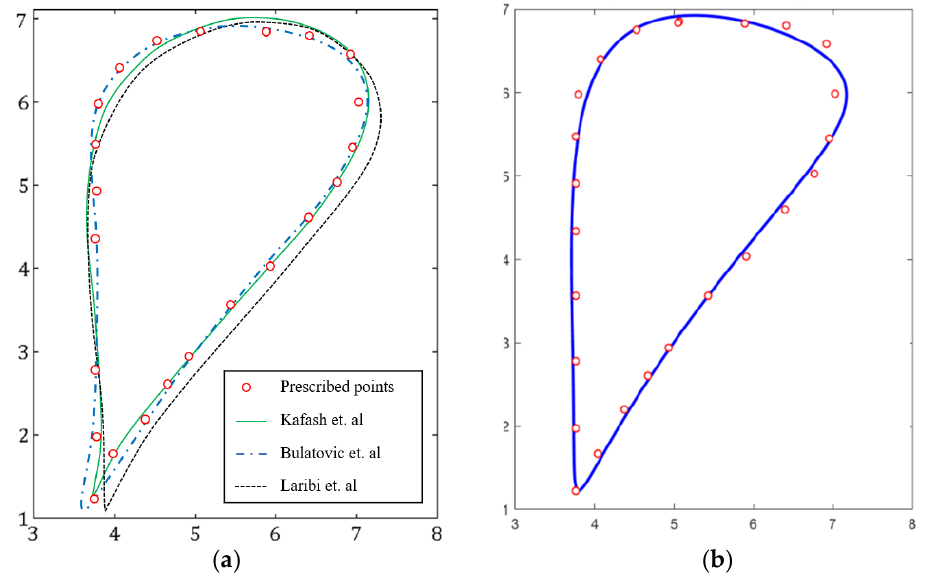
Figure 10. Example 2: optimal solution for: ( a ) four-bar and ( b ) slider-crank mechanism. Table 3. Example 2: Optimum design parameters and inputs.